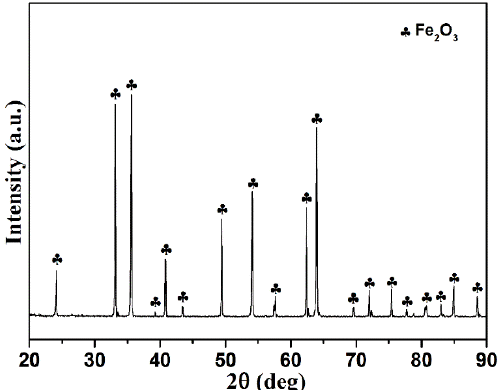
Figure 4. XRD patterns of the Fe-Cr-Zr alloy oxidized in air at 923 K for 1000 h.